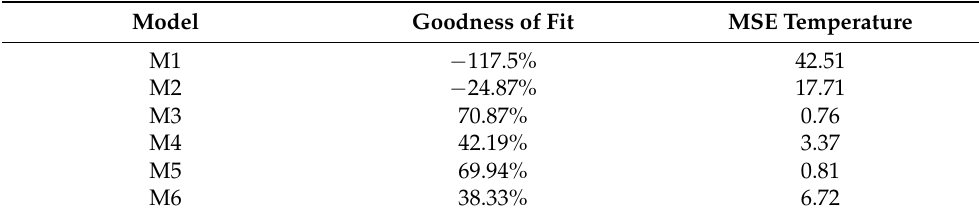
Table 2. Model output in a closed loop to track indoor temperature for TRNSYS.